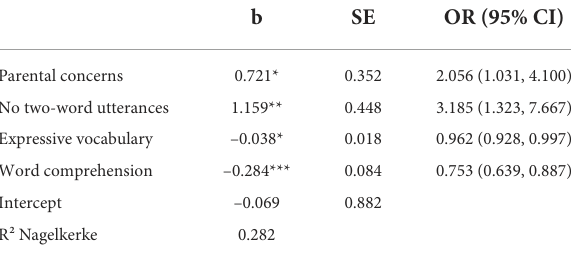
TABLE 3 Logistic regression predicting LD at age 3 – Stage